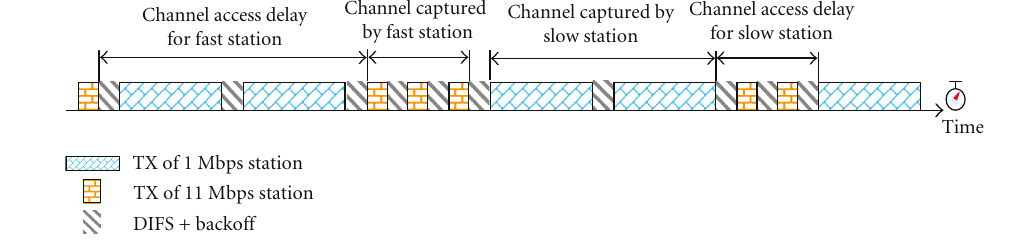
Figure 8: Short-term unfairness.